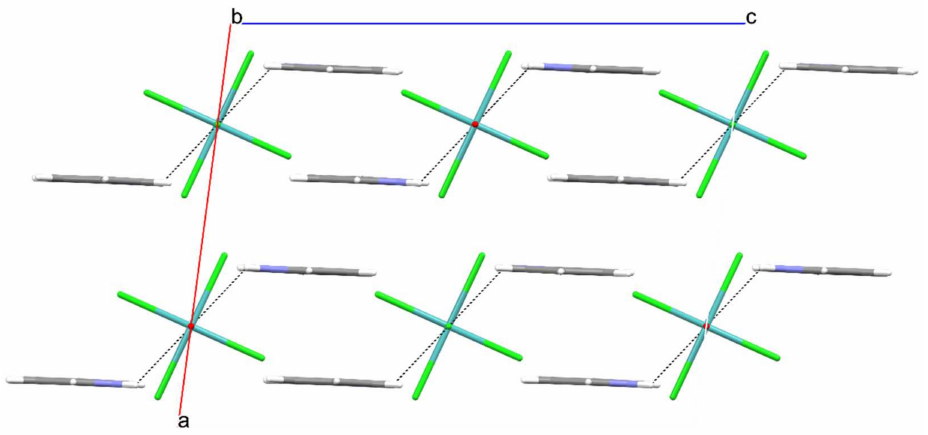
Figure 3. Packing of ions in (PyH) 2 [MoOCl 5 ]: a view along b